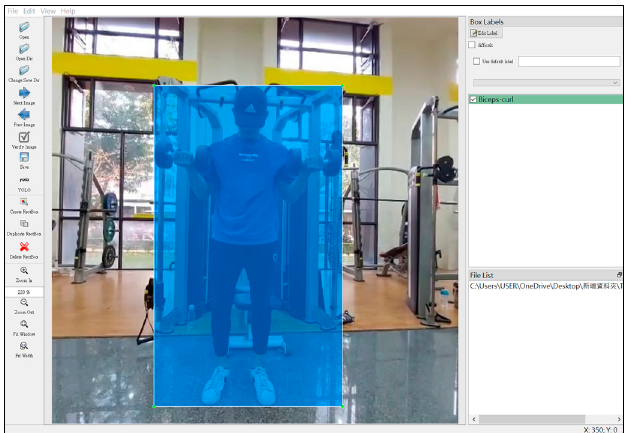
Figure 2. Labeling process using LabelImg.